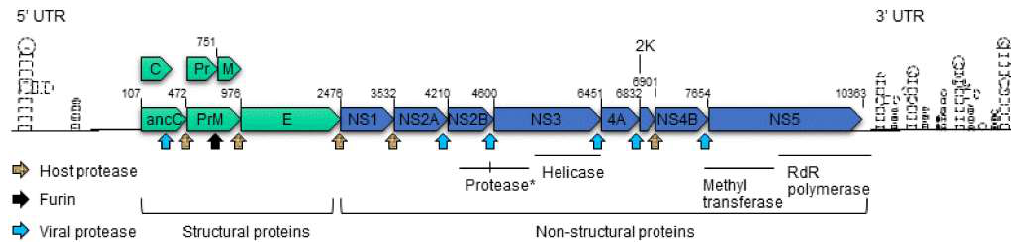
Figure 1. Schematic structure of the Zika virus genome. Each of the viral proteins is drawn based on the relative orientation in the RNA genome. The ZIKV viral protease, host protease and Furin protease are represented by different arrows, as shown. Each arrow points to the specific protease cleavage site. The numbers shown above each protein product indicate the start/end position. Abbreviations: anaC, anchored capsid protein C; C, capsid protein C; prM, precursor membrane protein; M, membrane protein; Pr, protein pr; E, envelope protein; NS, nonstructural protein; *, protease consists of N-terminal of NS3 and C-terminal NS2B as described in the text. C-terminal of NS3 encodes helicase; 2K, signal peptide 2K; NS5 encodes methyltransferase at its N-terminal end and RNA-dependent RNA (RdR) polymerase at its C-terminal end. UTR, untranslated region. The structures of 5′ UTR and 3′ UTR are based on [21]. The information of ZIKV protein products is based on [9].